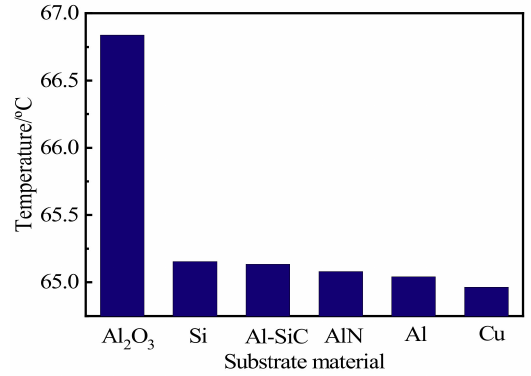
Figure 3. Junction temperature of different substrate materials.